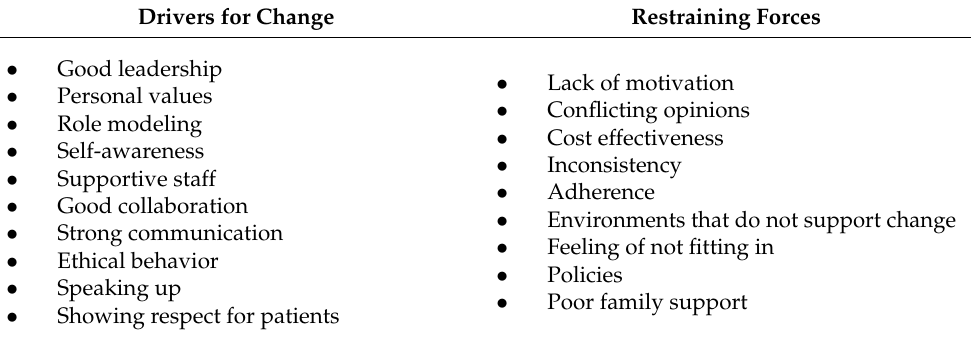
Table 2. Force field